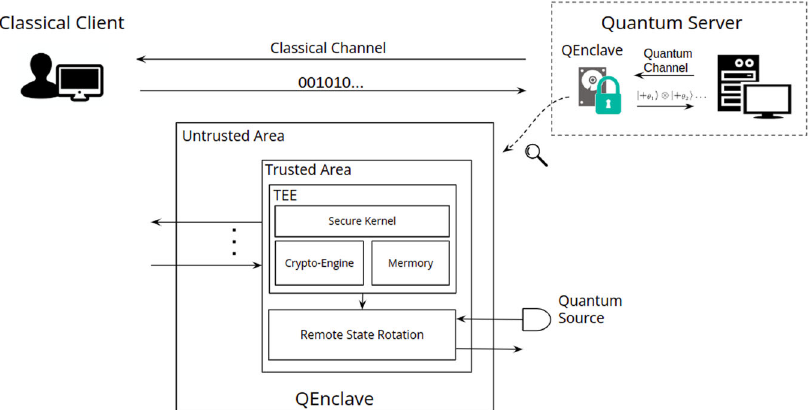
Fig. 2 Speci fi cation of QEnclave. The structure of QEnclave on the server ’ s side is divided into two areas: the trusted and untrusted areas. The rotation angles from the client can not be revealed until the rotation is performed inside the trusted area. The quantum source is external to the